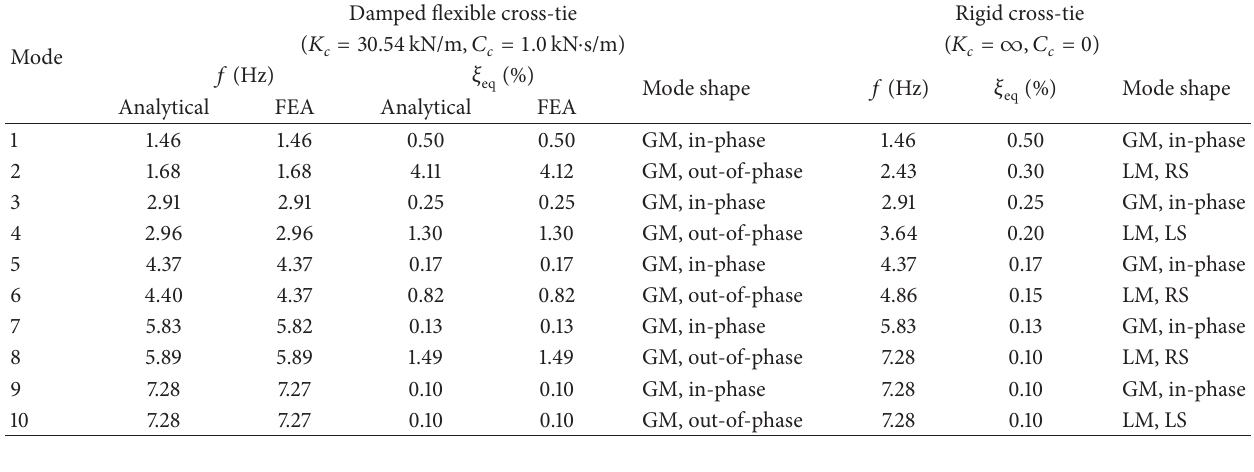
Table 2: Comparison of modal properties of a twin-cable network with damped flexible or rigid cross-tie at 𝜀 = 2/5 . Damped flexible cross-tie Rigid cross-tie Mode